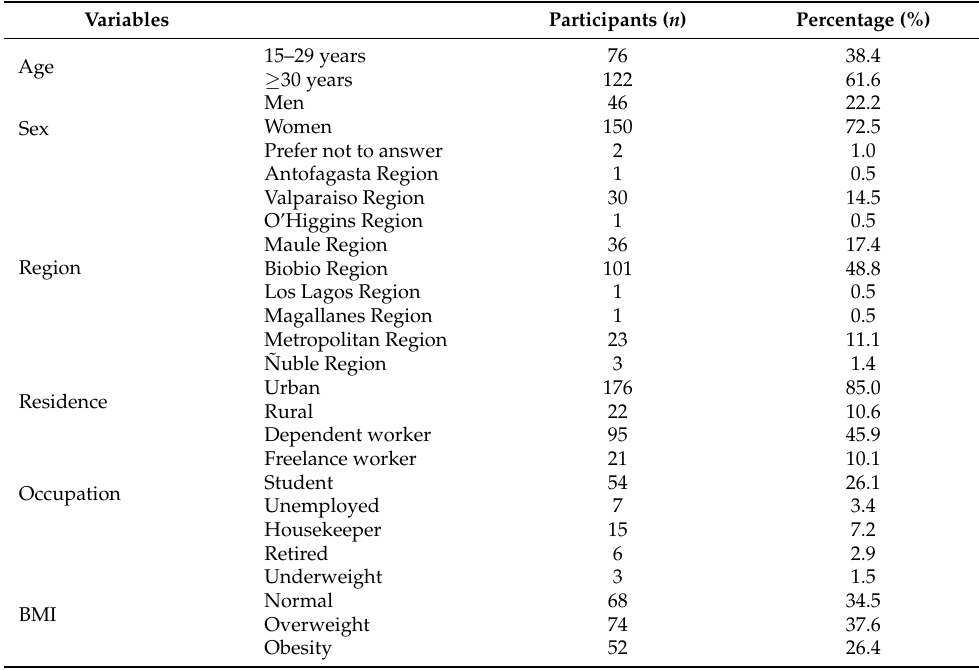
Table 2. Descriptive analysis of sociodemographic variables and nutritional status ( n =